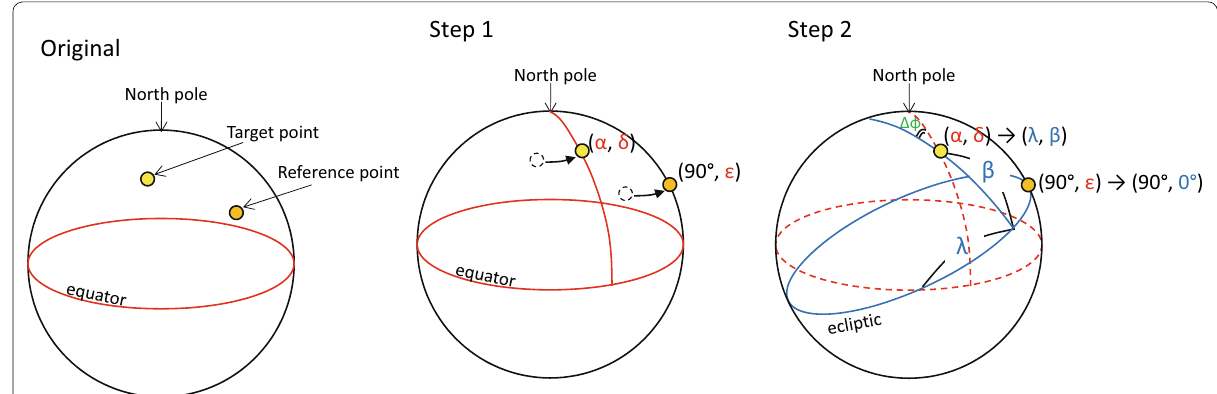
Fig. 3 Schematic view for converting equatorial coordinates to ecliptic coordinates. Yellow circle is a target point with the converted coordinates. Orange circle indicates the reference point on the simulation